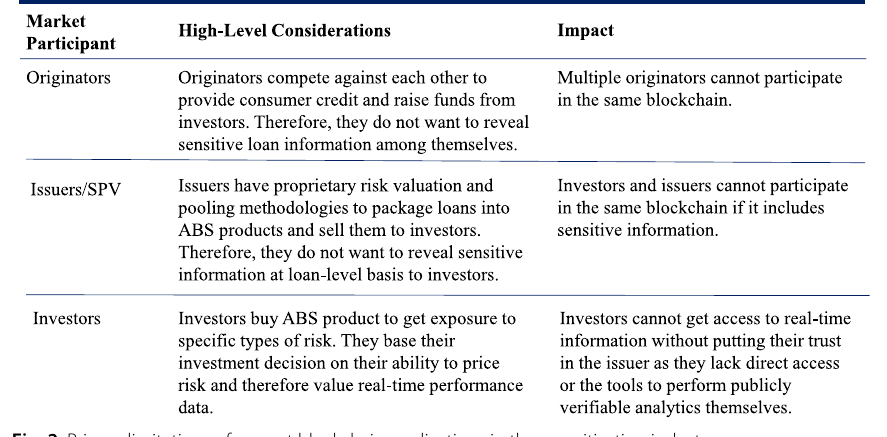
basis but are not expected to join the issuers’ blockchain and thus will lack the tools to perform their due diligence independently. Similarly, current blockchain applications do not yet allow for multiple competing issuers to join the same universally agreed-upon ledger and therefore face limitations for applications at the industry